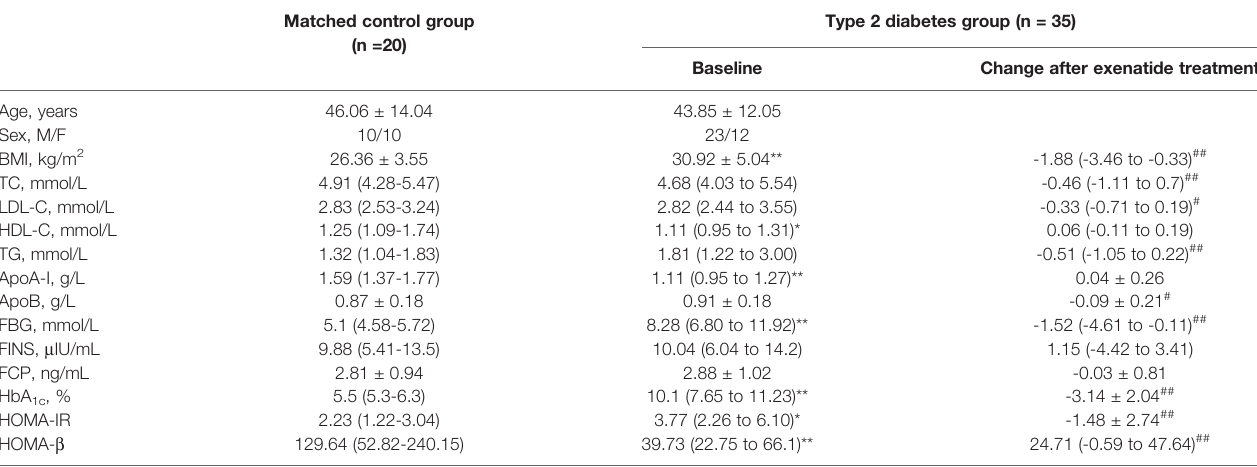
TABLE 1 | Baseline characteristics of study